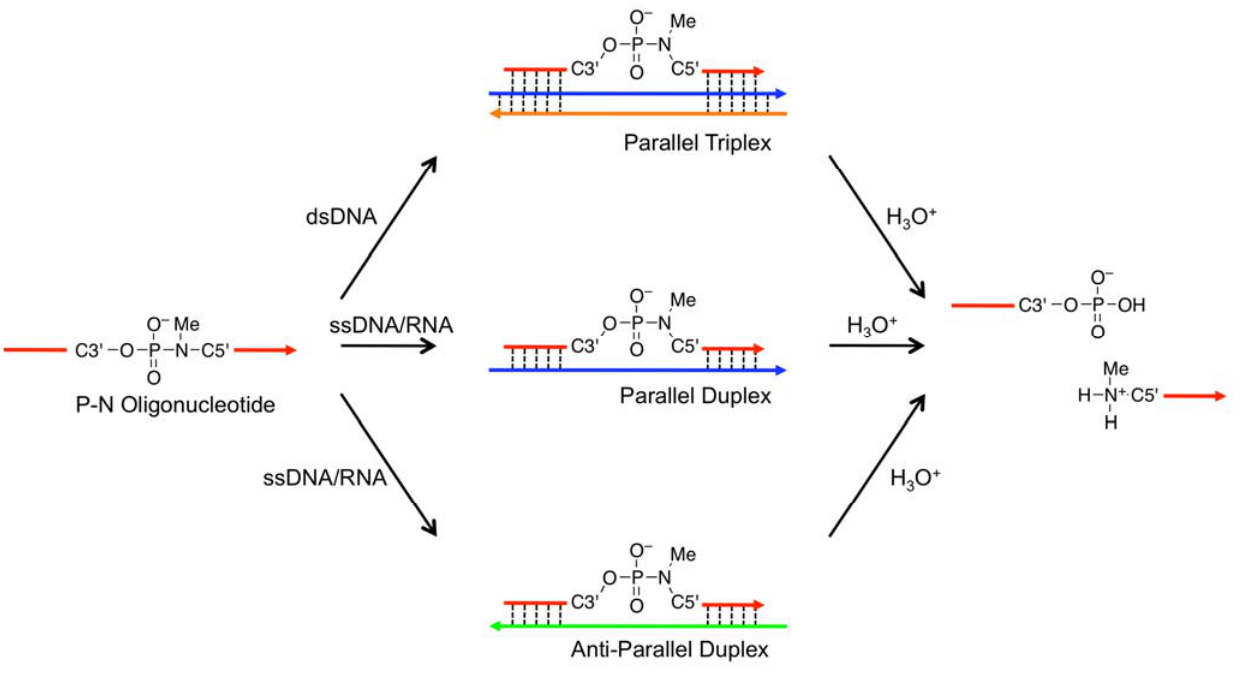
Figure 2. Schematic representation of nucleic acid-templated hydrolysis of phosphoramidate. Template nucleic acids can be dsDNA or parallel or anti-parallel single-stranded nucleic